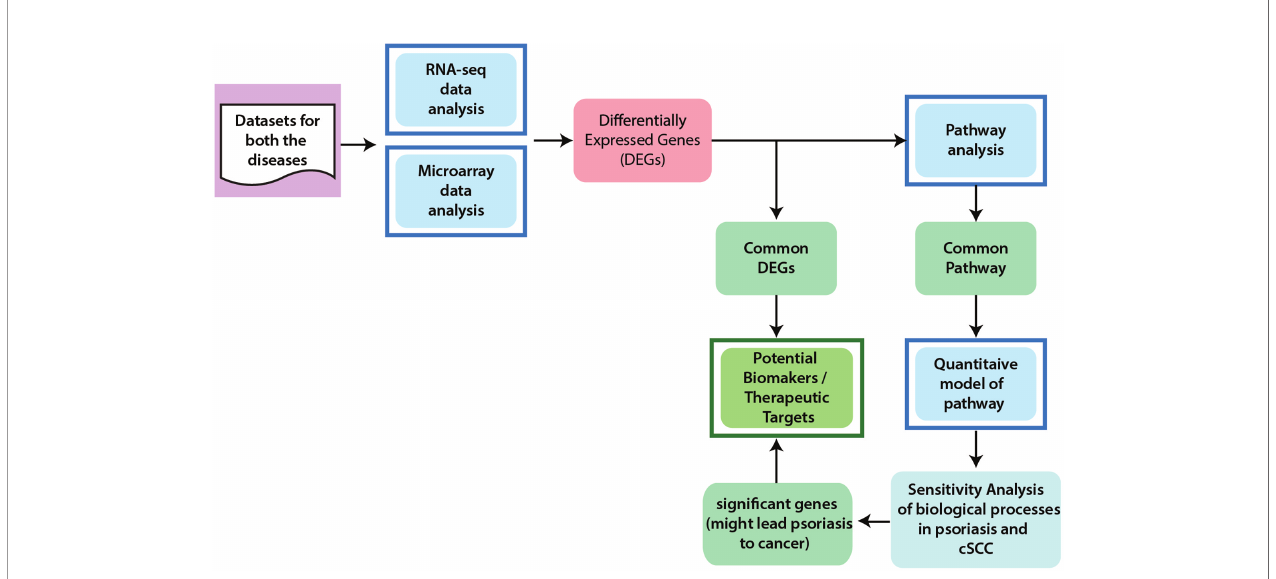
FIGURE 1 | General Work fl ow of the Project. In order to achieve the aims and objectives of this study, integrated data analysis of microarray and RNA-seq were performed for cSCC and psoriasis. From differential expression analysis, common DEGs between psoriasis and cSCC were identi fi ed that are proposed as potential biomarkers and therapeutic targets for both the diseases. Pathway analysis was then performed to analyze the disrupted pathways and their possible relation with the disease. The signi fi cant pathways (at p-value <= 0.05) from every dataset were then compared for common pathway. As a result of this comparison, one common pathway, named IL-17 signaling pathway, was identi fi ed. Afterwards, quantitative systems biology was implemented to analyze the results at a holistic level. A sub-section of complete IL-17 pathway was modeled by using SimBiology application in Matlab (30). The average expressions values of DEGs that were present in the pathway were calculated for microarray datasets of psoriasis and cSCC. The model was then simulated by adding the average expression values. After simulation of the model, sensitivity analysis was performed to analyze the response of the biological processes to model quantities (DEGs and genes). Sensitivity analysis of the biological processes of both psoriasis and cSCC revealed signi fi cant genes that might lead psoriasis to cancer and could also be proposed as potential biomarkers and therapeutic targets of both the